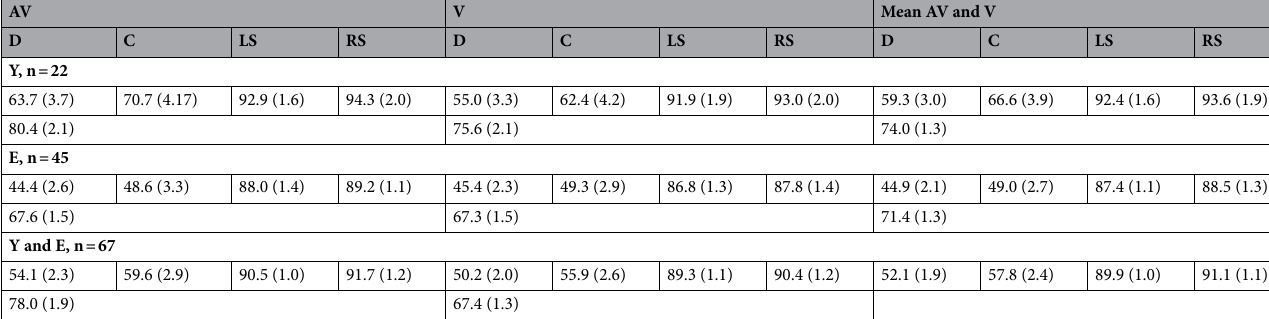
Table 3. Gain amplitude means and standard errors. Means and sd in % of the gain amplitude, by group age, movements and targets modalities. Y for the young group. E for the elderly group. A for auditory targets, AV for audiovisual targets. D for divergence, C for convergence, LS for left saccades, RS for right saccades.